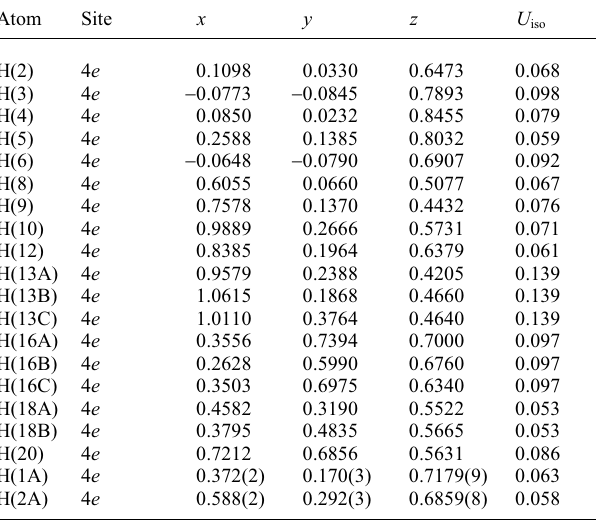
Table 2. Atomic coordinates and displacement parameters (in Å 2 )